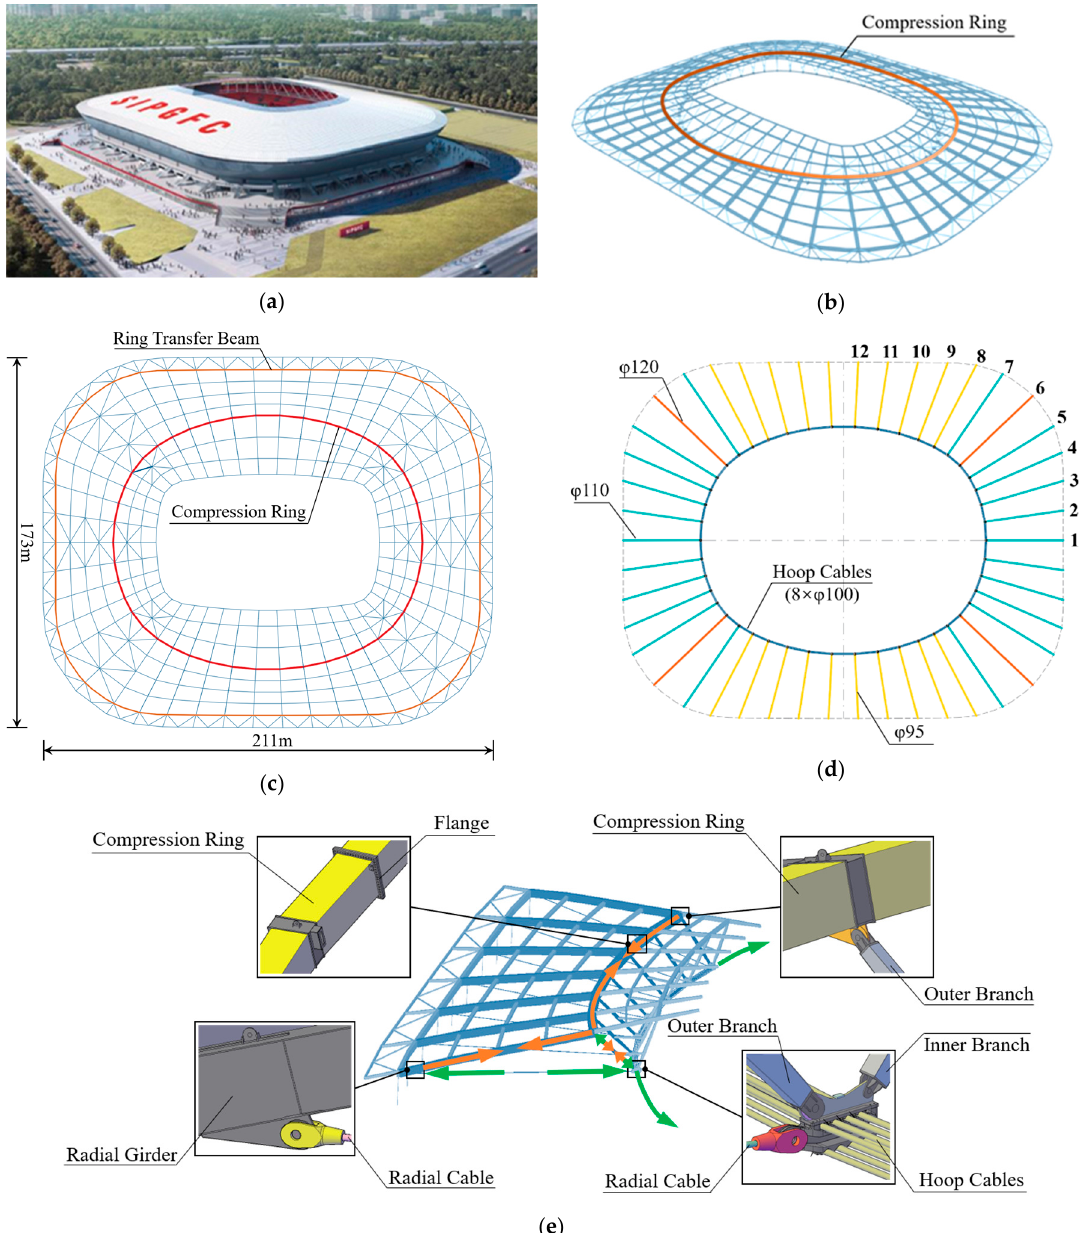
Figure 2. Schematic of Pudong Football Stadium: ( a ) effect picture; (b) three-dimensional view; ( c ) plan view; ( d ) radial cable distribution; ( e ) node detail diagram.